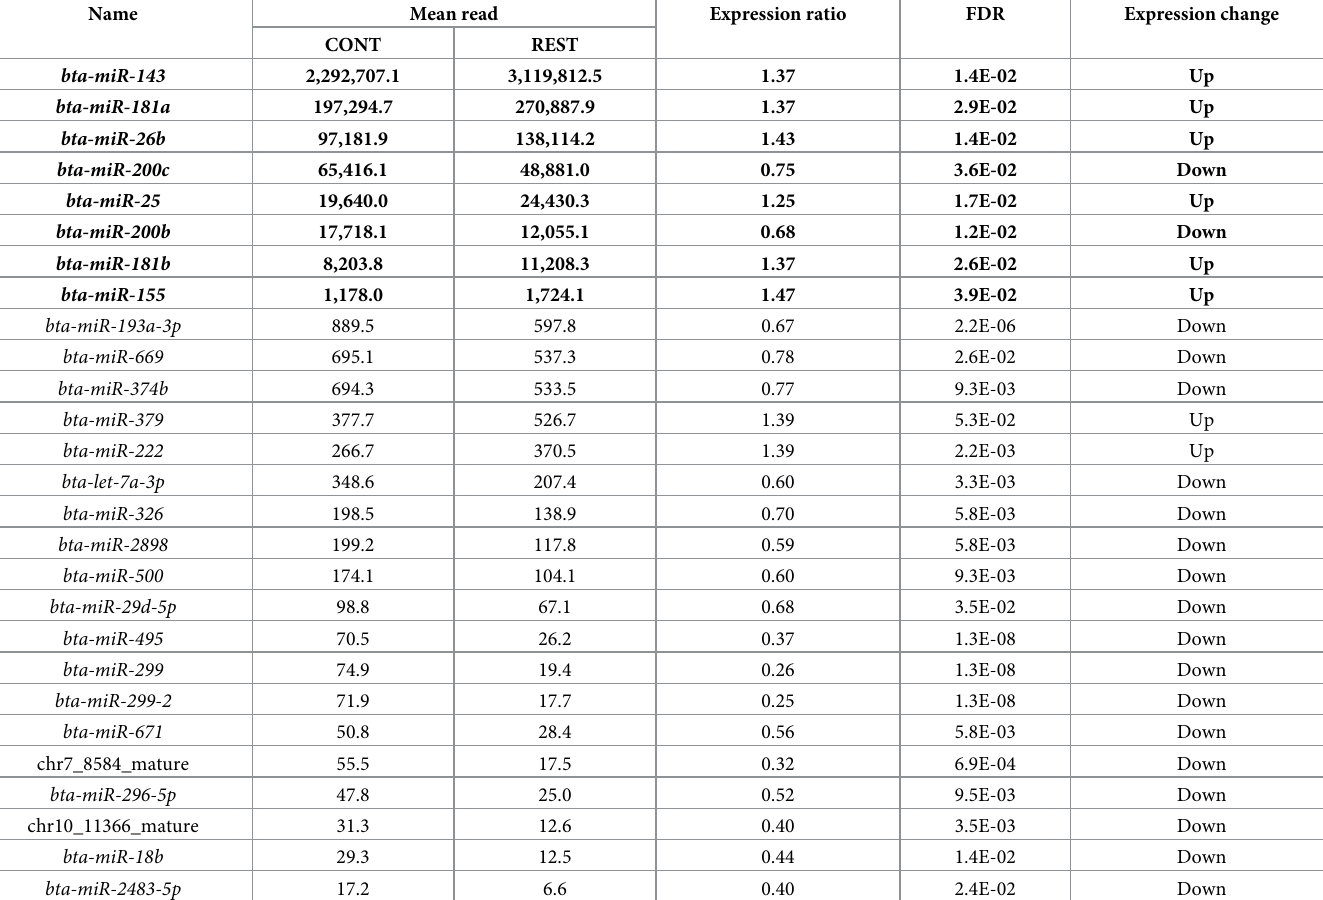
Table 3. Differentially expressed miRNAs in the mammary gland of midlactation Holstein cows during restriction (REST) compared to the control (CONT) period. Name